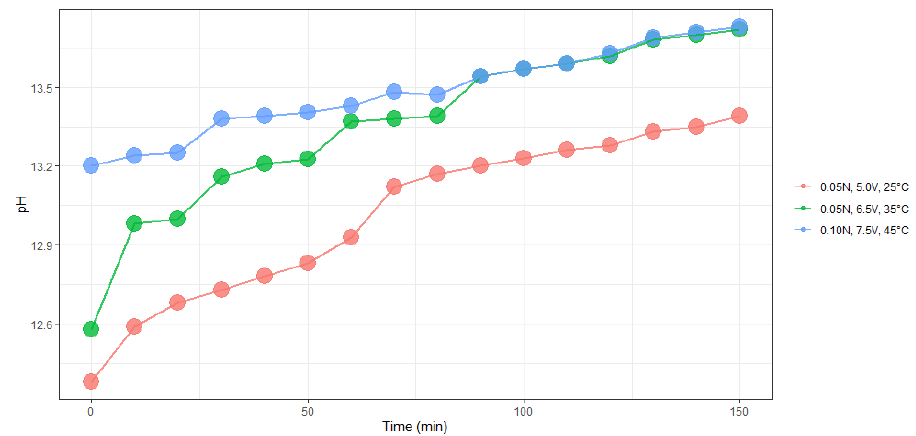
Figure 8. Sodium hydroxide pH evolution